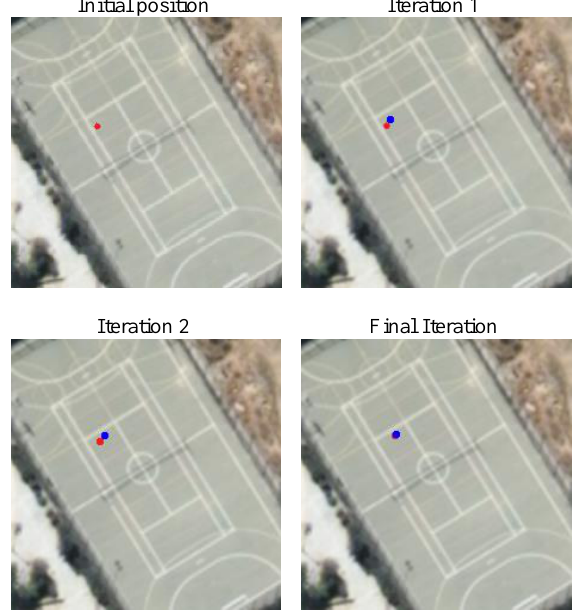
Figure 5: Photocoordinates position